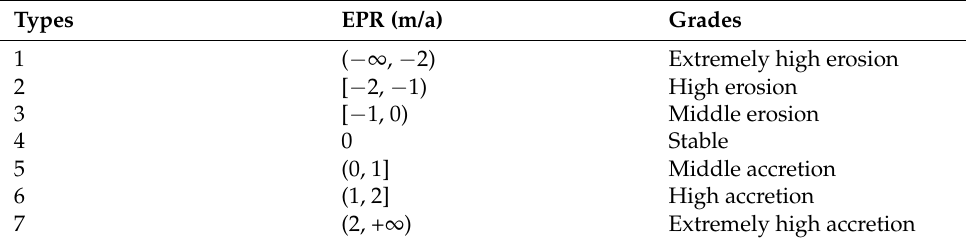
Table 3. Coastal erosion and accretion grades.